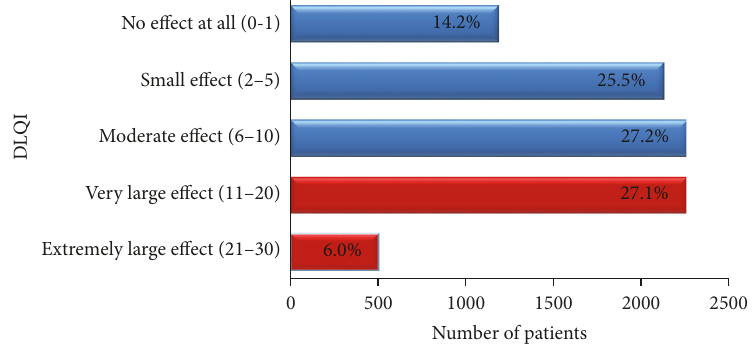
Figure 2: Quality of life in adult patients with